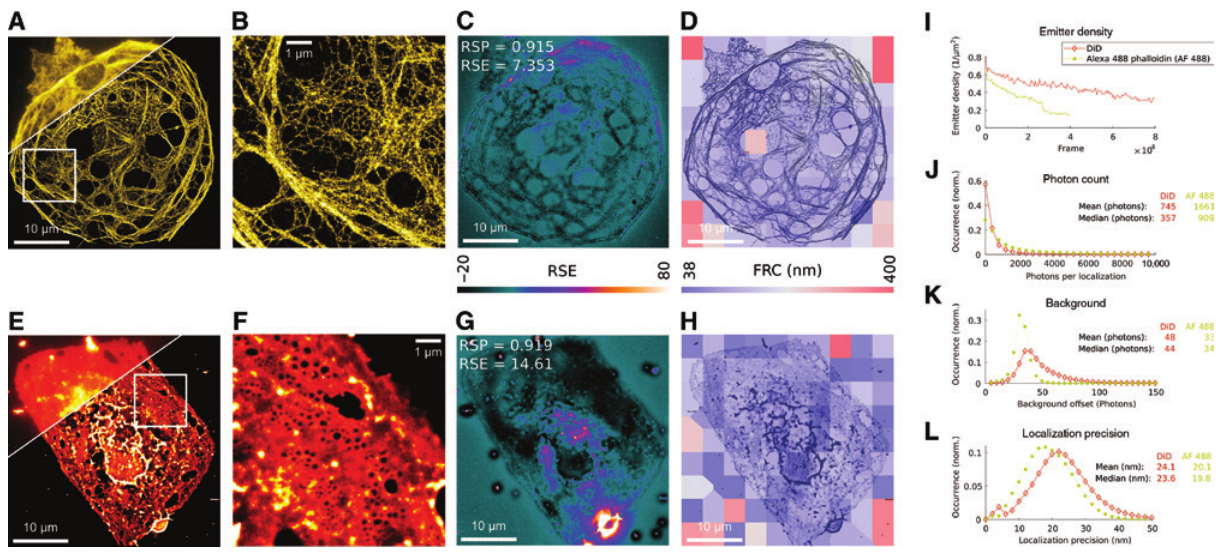
Figure 3: dSTORM imaging quality characterization. Rat LSEC diffraction limited (A, E, upper left) and dSTORM images of actin (A, B) stained with AF488-phalloidin and membrane (E, F) stained with Vybrant DiD. Spatially dependent dSTORM image quality metrics of RSE (C, G) and FRC resolution (D, H) determined by SQUIRREL. (I) Emitter density in the ROI of (B, F) as a function of the frame. (J–L) The single molecule localization statistics (AF488 and DiD) as photon counts per localization, background and localization